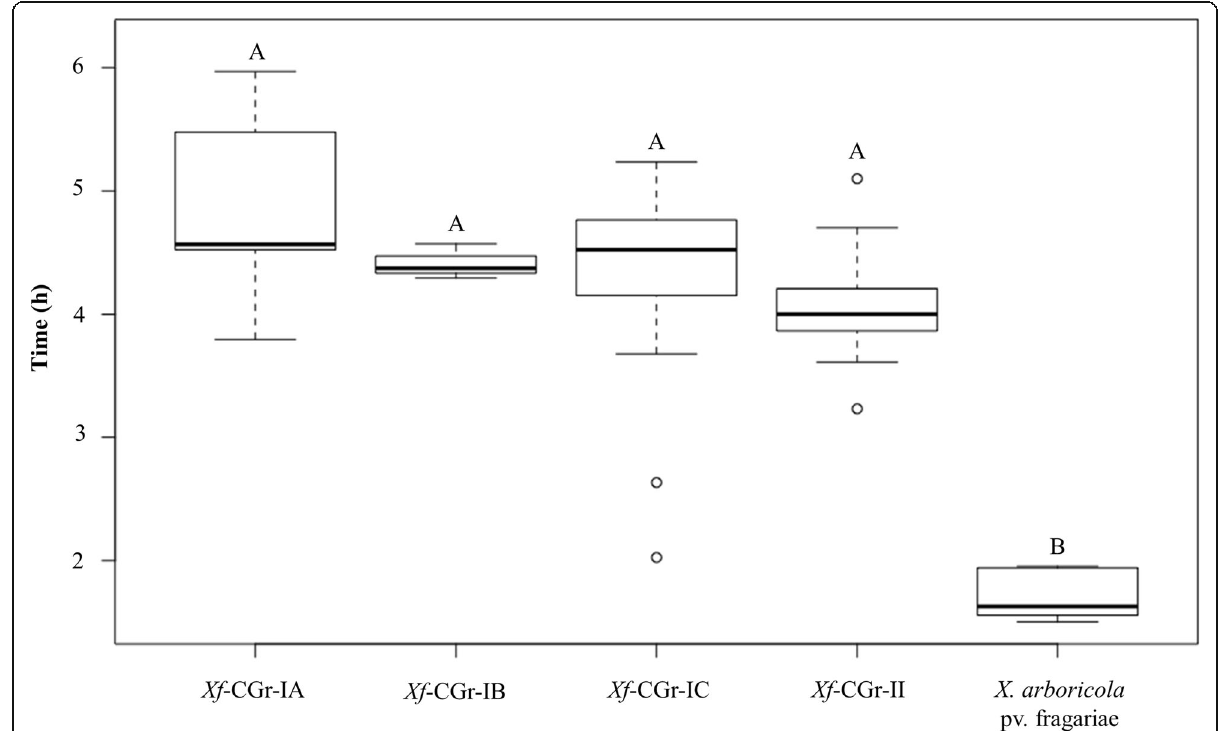
Fig. 5 Generation time of each Xanthomonas fragariae (sub)group and Xanthomonas arboricola pv. fragariae strain. Each box represents a given strains set of (sub)group Xf -CGr-IA ( n = 5), − IB ( n = 3), − IC ( n = 30) or -II ( n = 20) or X. arboricola pv. fragariae ( n = 5). The median, error bars as well as outlier per group are represented on this boxplot. Letters A and B are used to show the statistical intraspecies and interspecies relationship and reflect both X. fragariae and X. arboricola pv. fragariae. Intraspecies variation was not significant ( p- value > 0.05) whereas interspecies variation was significant ( p- value <